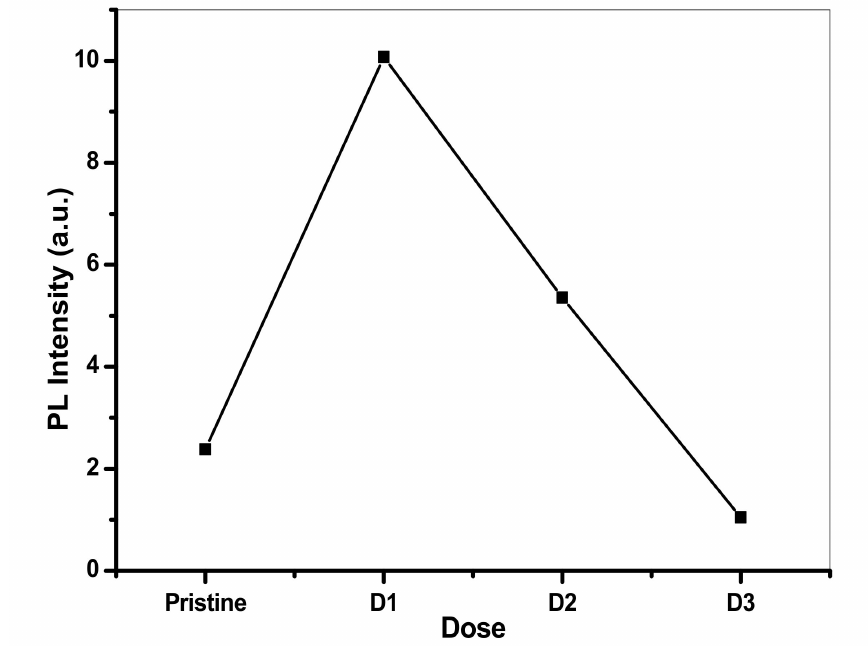
Figure 7. Dose vs. obtained